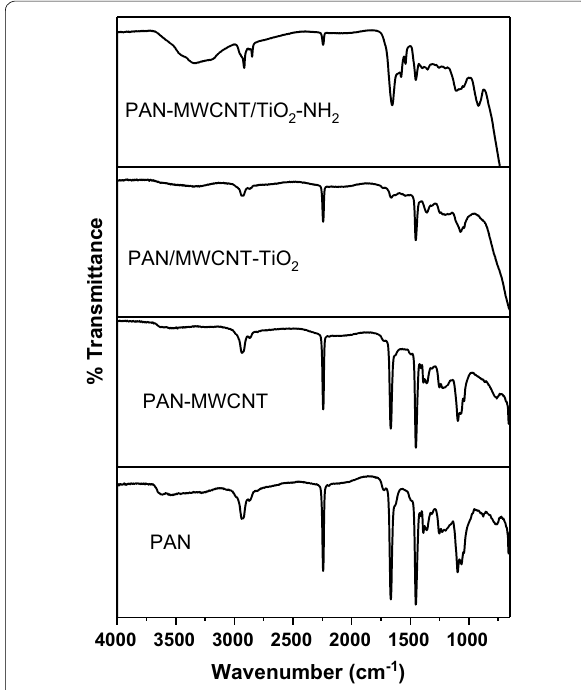
PAN-MWCNT/TiO 2 –NH 2 composite nanofibers